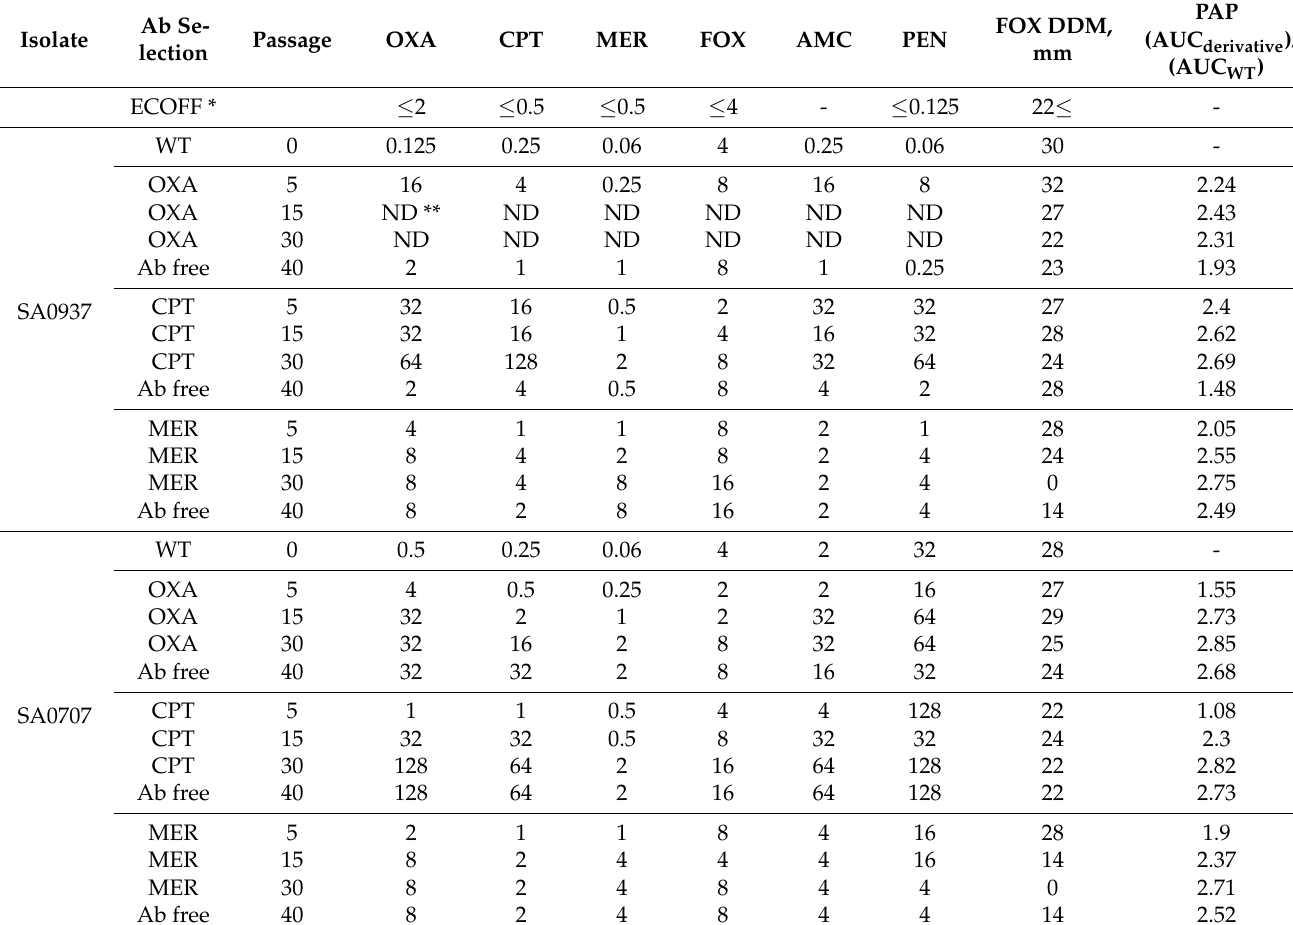
Abbreviations: WT, wild type strain; Ab free, passages on antibiotic-free medium after resistance selection; OXA, oxacillin; CPT, ceftaroline; MER, meropenem; FOX, cefoxitin; AMC, amoxicillin and clavulanic acid; PEN, penicillin, FOX DDM, disk-diffusion method with FOX; PAP, population analysis profile. * According to EUCAST data (https://mic.eucast.org/) accessed on 31 March 2021; ** ND—not-detectable results; derivative isolate SA0937 after selection on oxacillin could not grow in Muller-Hinton